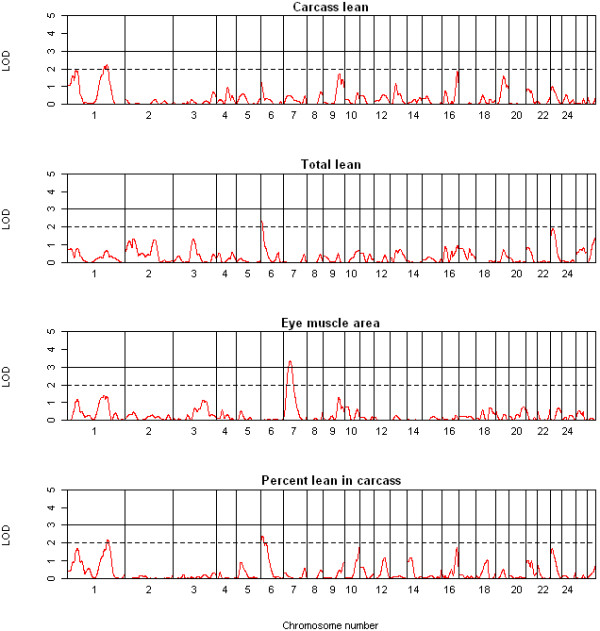
QTL map of the entire genome for carcass lean, total lean, eye muscle area and lean percentage.